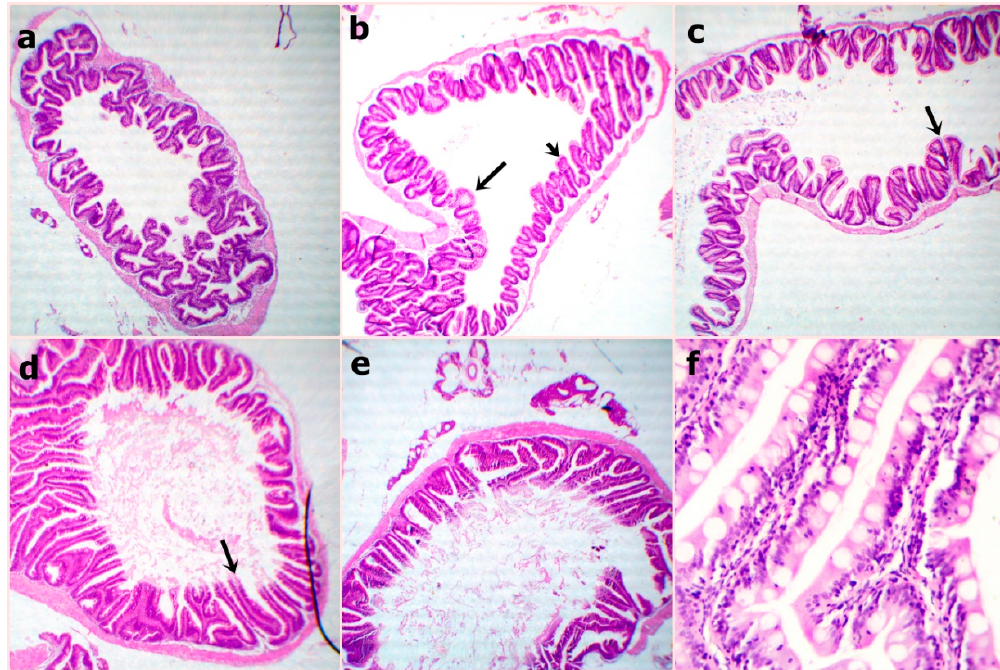
Figure 2. Representative photomicrograph of H&E stained sections from fish intestine at the end of the experiment showing ( a ) WPC0–reduced villus height and width at 40x; ( b ) WPC13.8—distinctly arranged tall villi at 40x; ( c ) WPC27.7—marked tall and branched villi with some broad tips (arrow) at 40x; ( d ) WPC41.6—marked very tall and thin villi (arrow) at 40x; ( e , f ) WPC55.5—clearly tall and thin villi with partially damaged tips (arrow) with reduced goblet cell count and inter-epithelium lymphocytic infiltration (arrow) at low 40x and high magnification 400x.